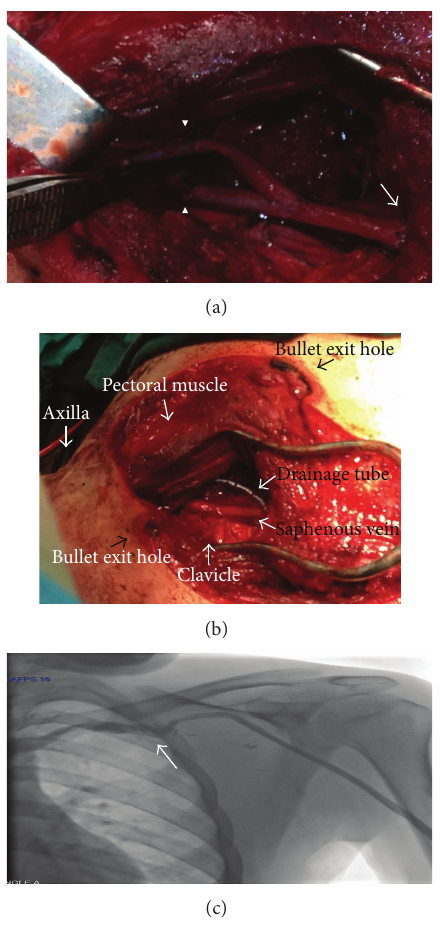
Figure 2: (a) Repaired venous segment; proximal (arrow) and distal anastomoses (arrowhead). (b) Injury site and incision line after vascular repair. (c) Venogram demonstrating venous blood flow obtain at postoperative 1st